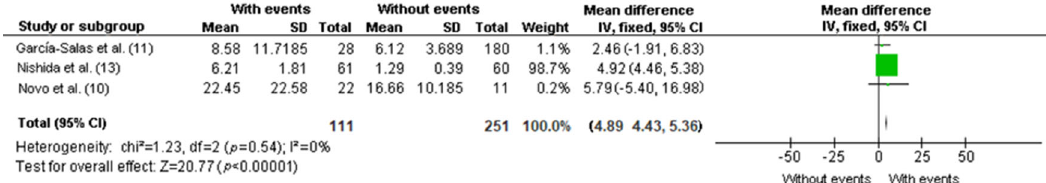
Figure 3 - Forest plot of the relationship between interleukin-6 and the risk of major adverse cardiovascular events during acute coronary syndrome follow-up. CI, confidence interval; df, degrees of freedom; SD, standard deviation.